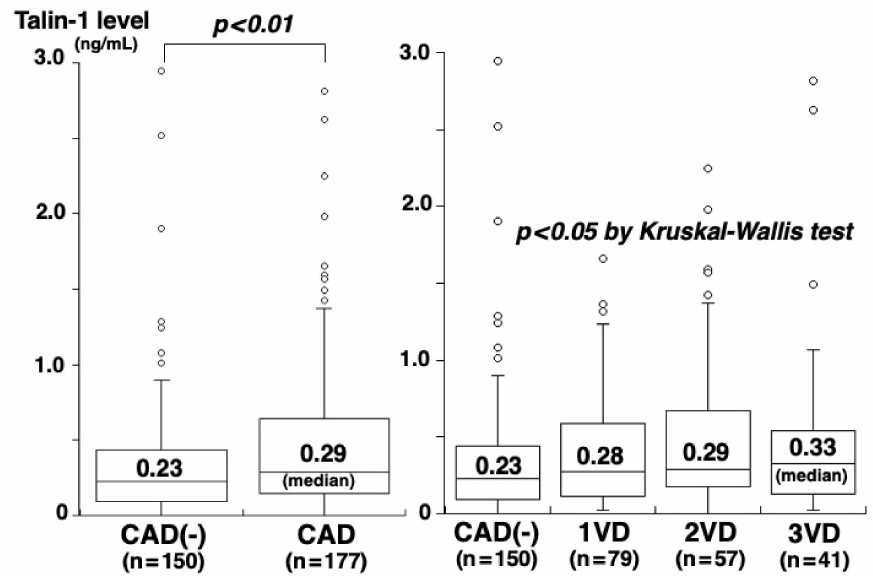
Figure 3. Plasma talin-1 concentrations and CAD or the number of vessels with >50% stenosis. CAD, especially the 3VD group, had higher talin-l concentrations than the CAD(-) group ( p < 0.01).